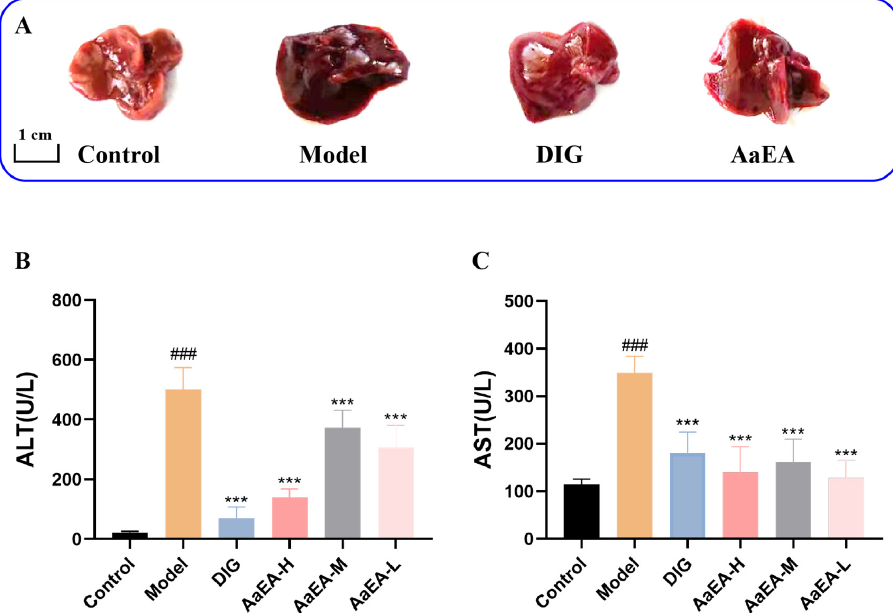
Figure 3. AaEA inhibited ConA-induced ILI in mice. Changes of liver tissues by the naked eye ( A ). Serum ALT activity ( B ) and AST activity ( C ) levels in different groups (n = 6). Unless indicated, no significant difference was observed between groups. Compared with control group, ### p < 0.001. Compared with ConA group, *** p < 0.001.